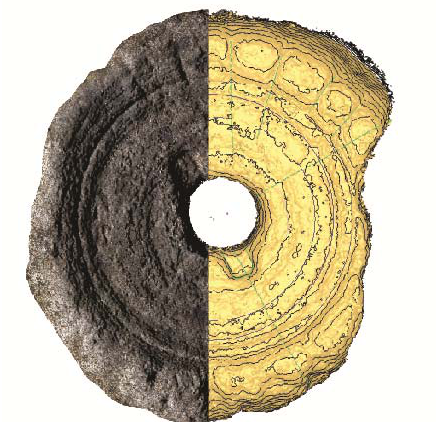
Figure 13. 3D model (left) and geometrical analyses (right) of the mill